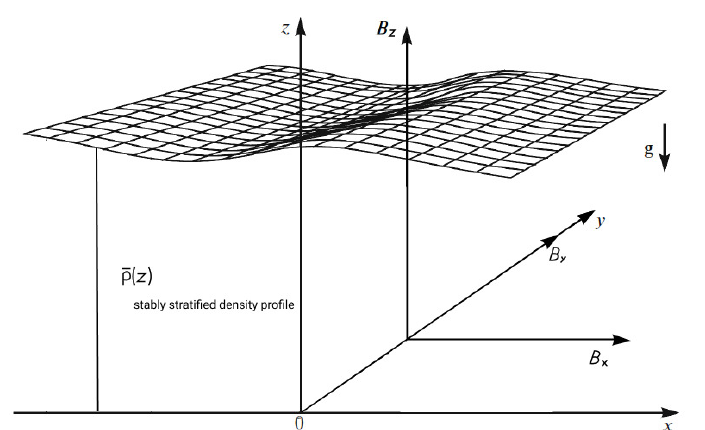
Figure 6. Geometry of a layer of plasma with stably stratified density profile. The flow density and temperature variations in Boussinesq approximation must be